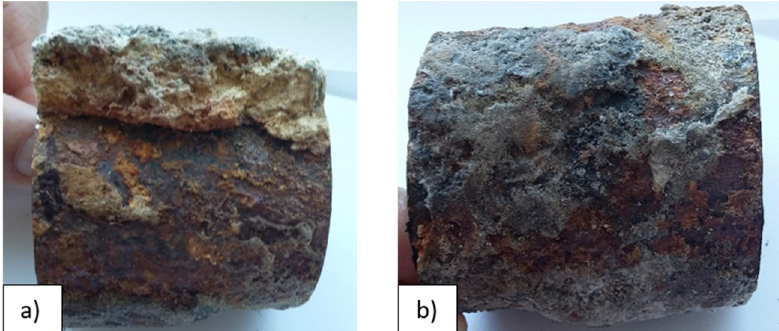
Figure 3. The cutout from the evaporator tube: ( a ) massive deposit layer on the cutout 1; ( b ) deposit layer on the cutout 2 (according to Figure 2).